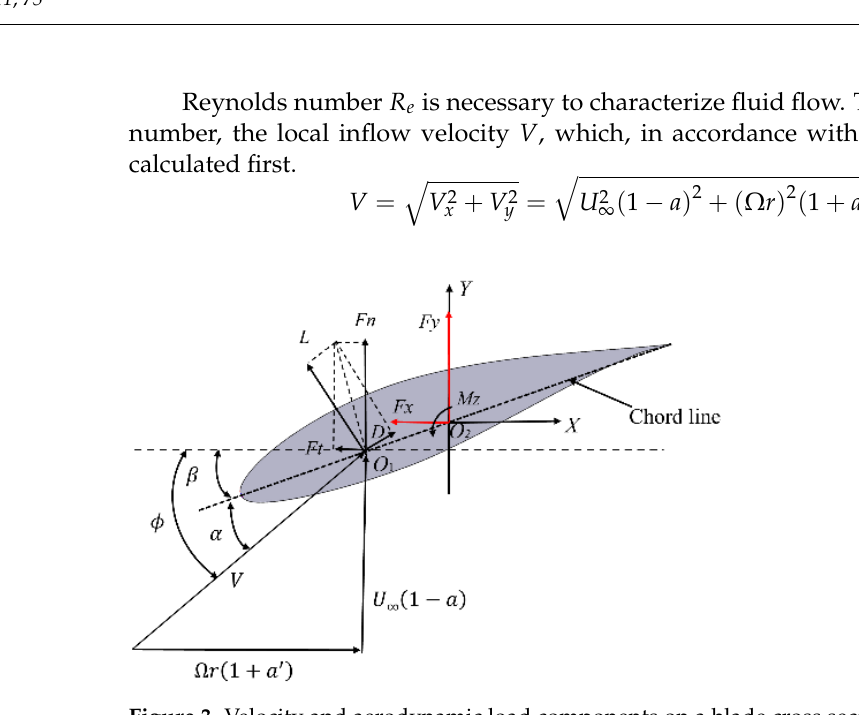
Figure 3. Velocity and aerodynamic load components on a blade cross section.